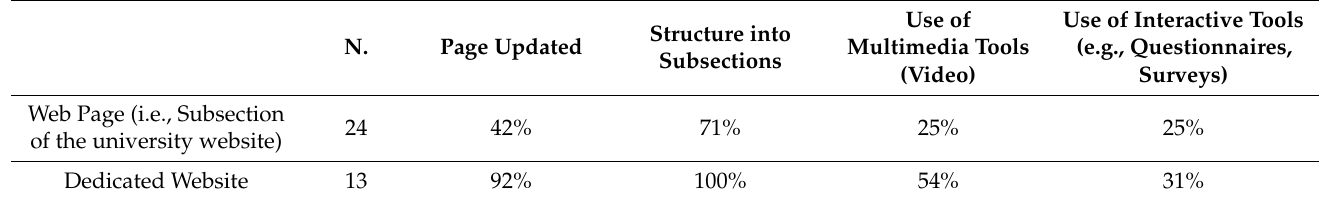
Use of Interactive Tools Use of Structure into (e.g., Questionnaires, Multimedia Tools Subsections Surveys) (Video)